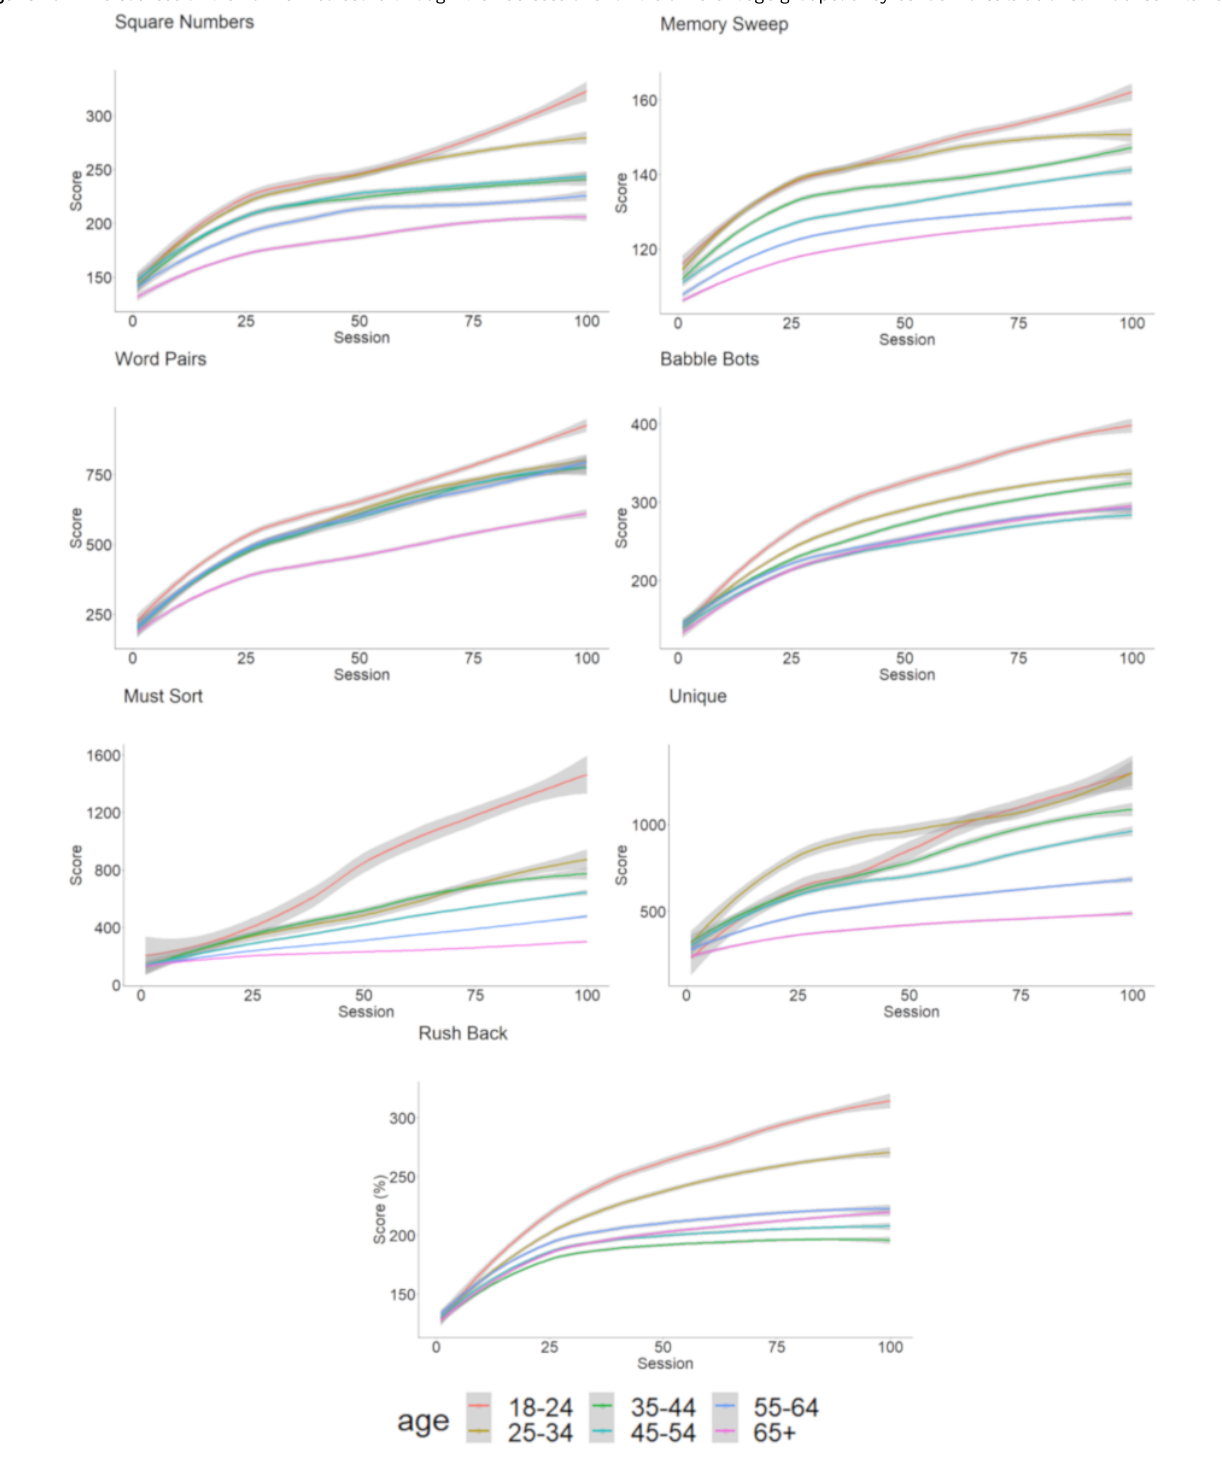
Figure 2. Time courses of the normalized score through the 100 sessions for the different age groups. Grey bands indicate 95% confidence